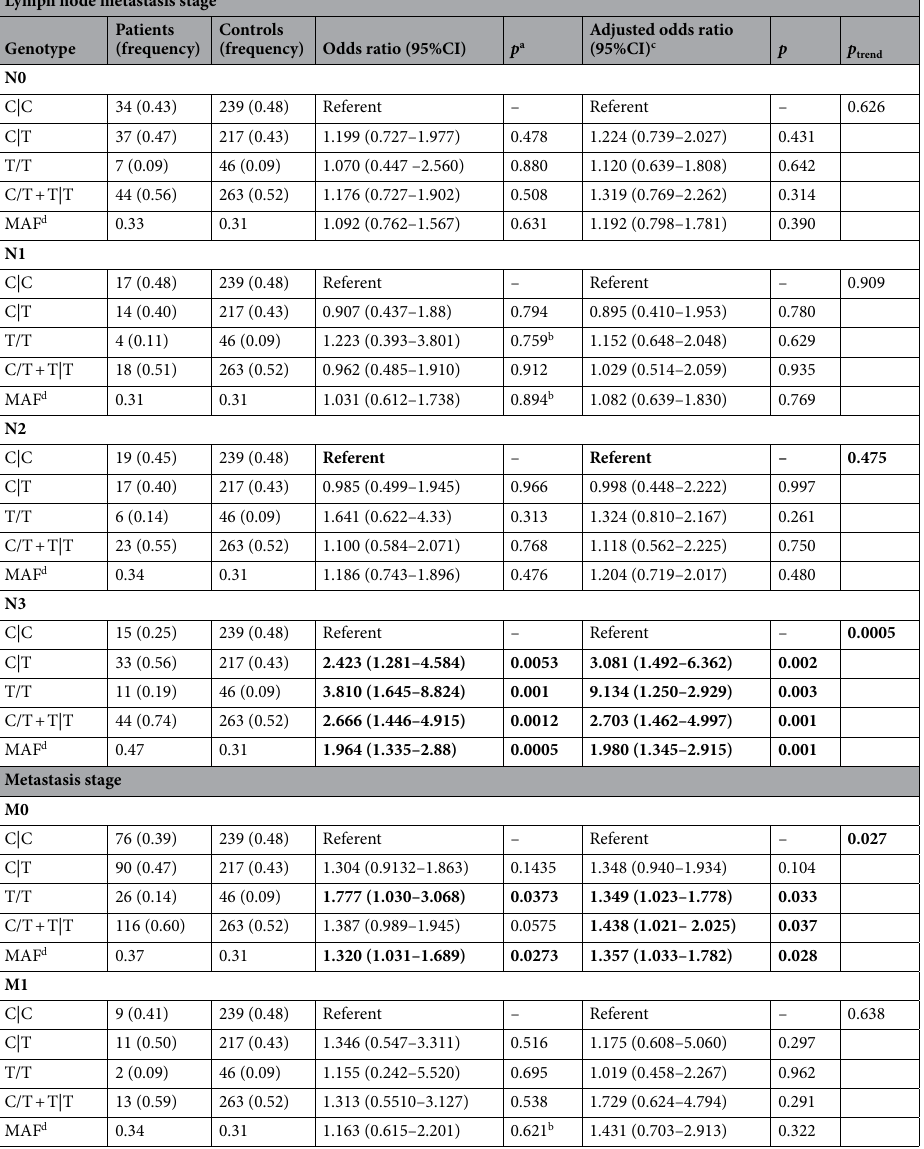
Table 5. Prevalence of the CCAT1 rs67085638 polymorphism among various lymph nodes and stages of metastasis of GC. Significant results are highlighted in bold font. a χ 2 or b Fisher’s exact test. c ORs were adjusted by age, BMI and presence of diabetes. d Minor allele